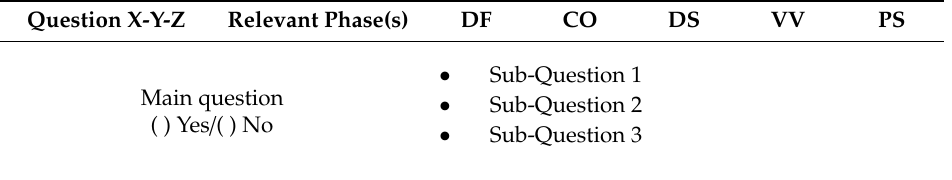
Table 3. Template for